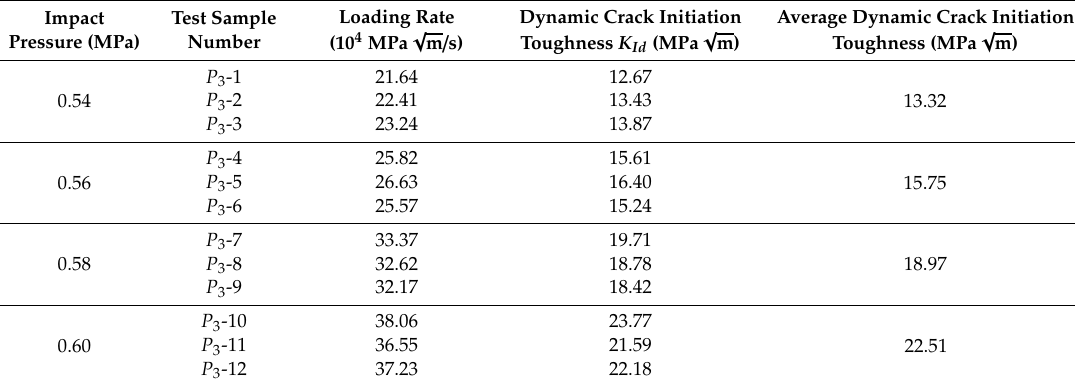
Table 5. Dynamic crack initiation toughness of shale loading with Crack-arrester.